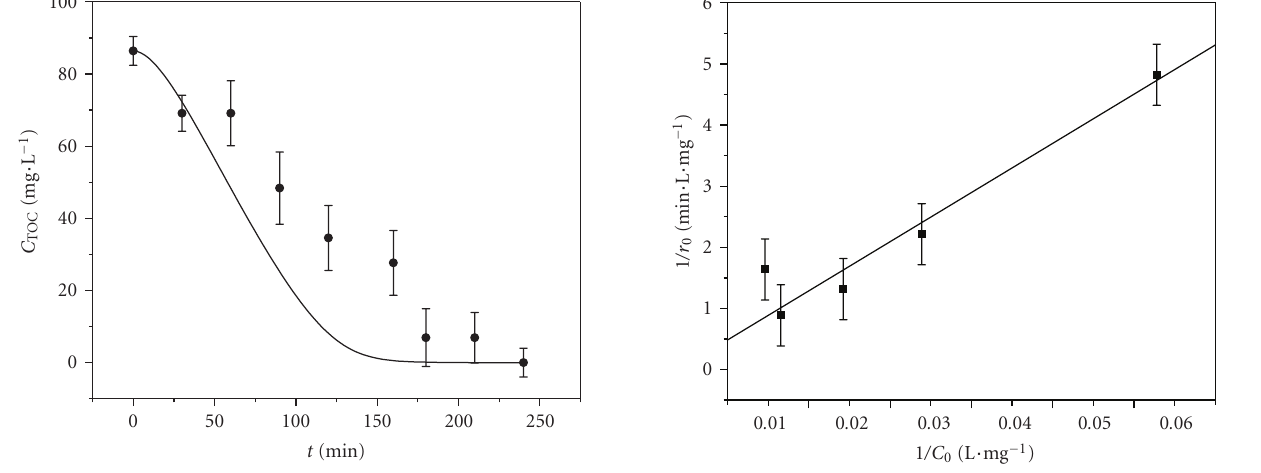
Figure 4: The Langmuir-Hinshelwood plot (4) reporting (1 /r 0 ) (in min · L · mg − 1 of mineralised carbon) as a function of (1 /C 0 ) (in L · mg − 1 of carbon), for all kinetic runs in which analysis has been carried out by COD measurements, these latter being transformed by calculation into total organic carbon. Absorbed radiation power per unit membrane length was 1.50 W · cm − 1 and overall reacting volume 4.0 L, in all the runs of this kind. In the laboratory- scale photoreactor (see Experimental), standard photocatalytic membranes, immobilising 30wt.% of P-25 titanium dioxide, were